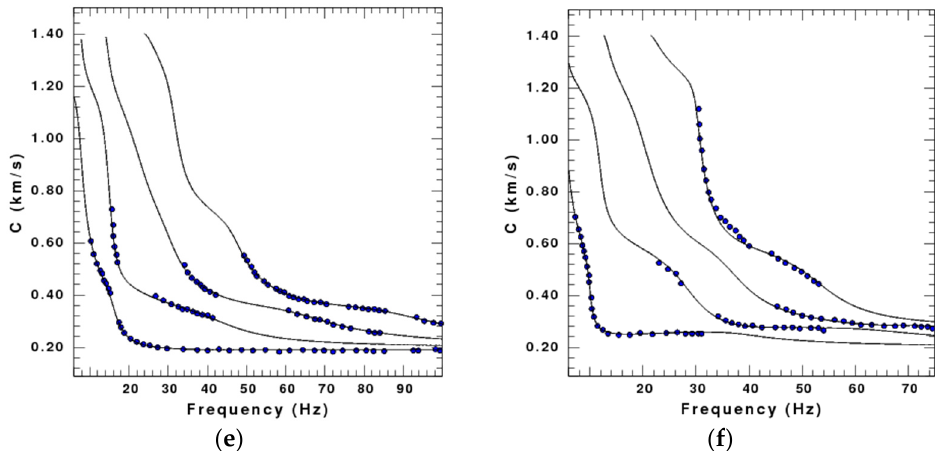
Figure 6. Dispersion curves for Model 1 and Model 2, where the black lines are the theoretical dispersion curves and different shapes of points correspond to the different modes. ( a ) X component of Model 1; ( b ) X component of Model 2; ( c ) Z component of Model 1; ( d ) Z component of Model 2; ( e ) R y component of Model 1; ( f ) R y component of Model 2. Table 3. Comparison of bandwidths among the radial, vertical and rotational data.